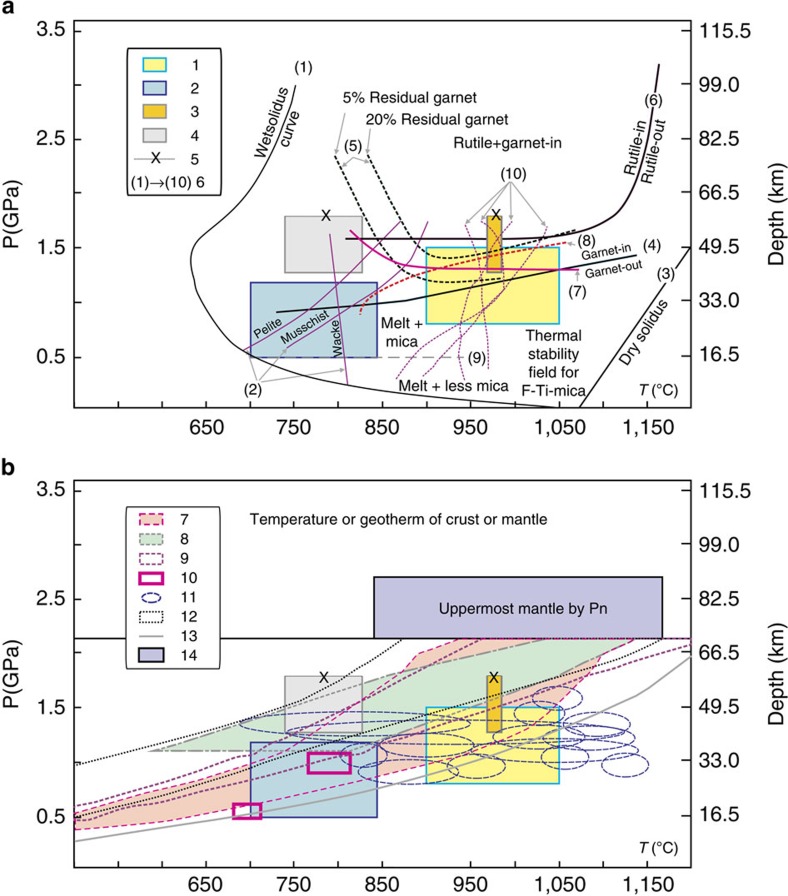
Crustal thermal state for central and northern Tibet.(a) Pressure–temperature conditions for partial melting of crustal rocks. 1–4, pressure and temperature conditions for magma generation (Supplementary Data set 1): (1) Quaternary (1.08–0.3 Myr ago) non-adakitic trachyandesites of the Songpan-Ganzi and Central Kunlun Blocks and Pliocene-Quaternary (4.7–2.3 Myr ago) non-adakitic felsic volcanic lavas from the central-northern Qiangtang Block; (2) Pliocene-Quaternary (4.0–1.5 Myr ago) rhyolites in the Songpan-Ganzi and Central Kunlun Blocks; (3) Pliocene (3.2–2.5 Myr ago) adakitic rhyolites in the Henglianghu area of the central-northern Qiang Block; (4) Pliocene (2.97 Myr ago) adakitic trachyandesites in the Zhaixinshan area of the Central Kunlun Block. (5) Adakitic magmas generated in the pressure range >1.2–1.5 GPa. (6) curves or lines for melting or mineral stability: (1) H2O-saturated or wet solidus curve of crustal rocks424870; (2) dehydration solidi curve for crustal rocks1747; (3) dry solidus curve70; (4) garnet-in/out curve during dehydration melting of metabasalts404243444748; (5) garnet proportion contours (5 and 20 wt.%) in the residue of metabasalt melting44; (6) rutile-in/out curve42; (7) plagioclase-in (beneath curve)/out (above curve) curve during dehydration melting4370; (8) orthopyroxene-in (beneath curve)/out (above curve) curve during dehydration melting70; (9) the boundary line for garnet-bearing (above line) and cordierite-rich (beneath line) melts during dehydration melting of metasedimentary rocks36; (10) upper thermal stability of F-free mica in pelite, wacke, mica schist and tonalite174748. The fields for melt+mica, melt+minor mica and thermal stability field for F-Ti-mica are after Hacker et al.17. (b) Constraints on the variations in pressure and temperature (thermal gradient) in the central and northern Tibetan crust. (7) Temperature in central Tibetan crust17; (8) temperature in the Qiangtang crust53; (9) temperature in the Qiangtang crust55; (10) temperature for α-β transition52; (11) xenolith temperatures for the Qiangtang crust23; (12) geotherm of the Northern Qiangtang-South Qaidam crust54; (13) geothem of the Northern Songpan crust35; (14) temperature of uppermost mantle by Pn51. These data are from geophysical17525354, crustal rock or granulite xenolith172335, and geophysical-petrological modeling studies55.